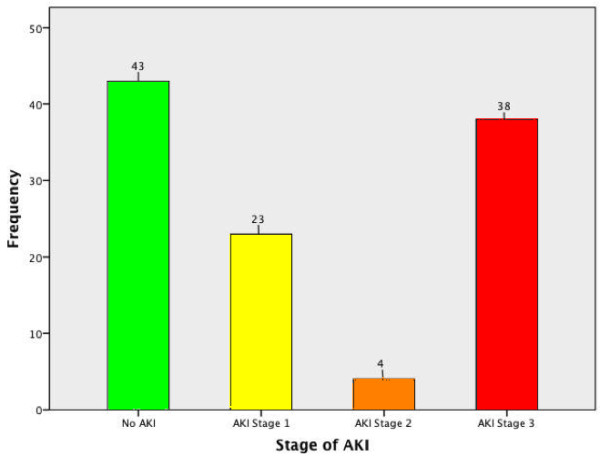
Frequency of AKI in ICU patients.